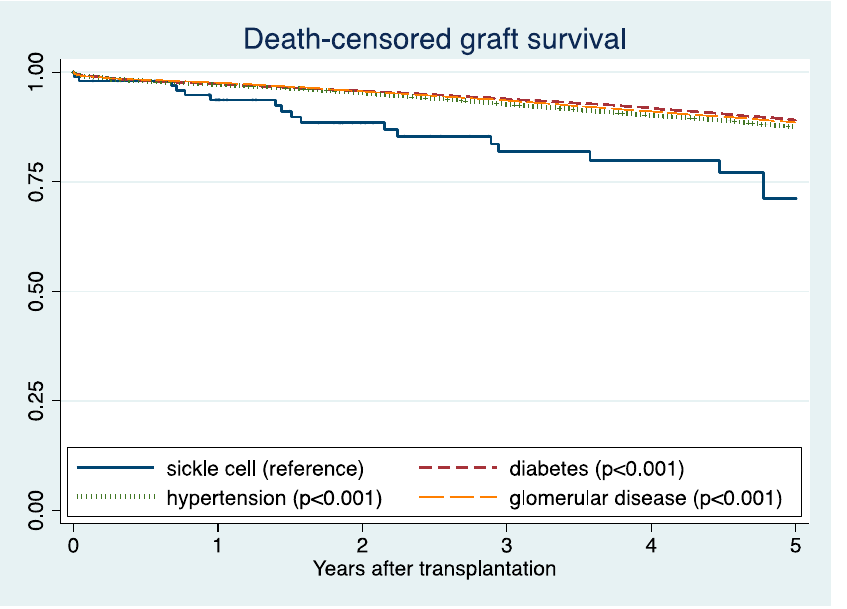
Figure 3. Death-censored graft survival according to the causes of end-stage kidney disease.